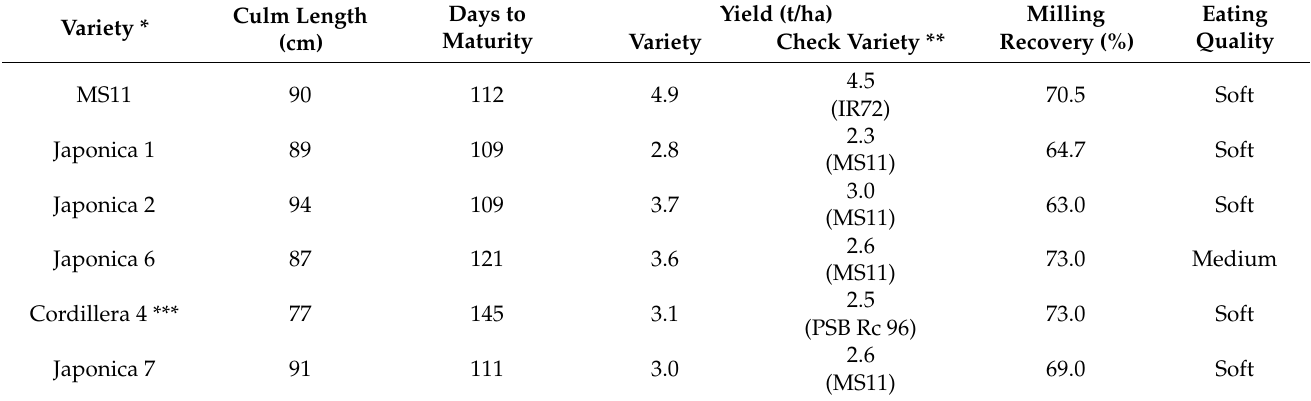
Table 2. Main agronomic traits of the temperate japonica rice varieties based on the NCT. Variety *